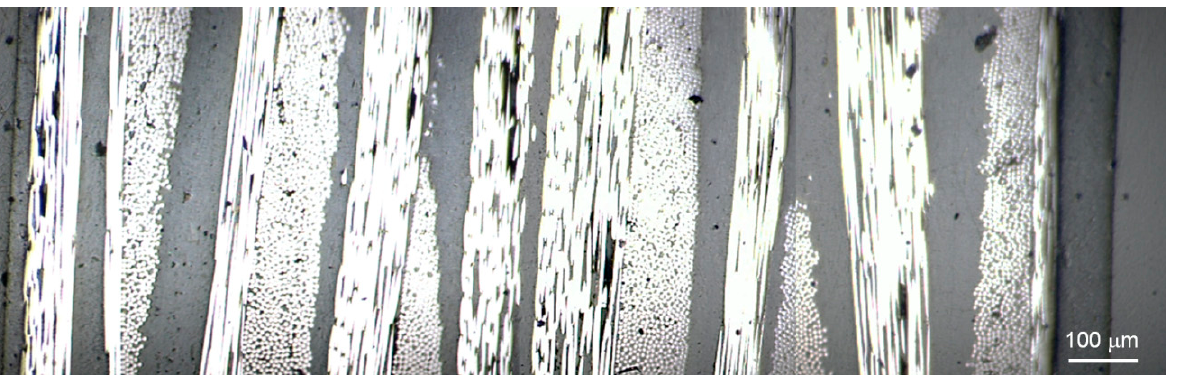
Figure 2. Photographs (upper row) and ultrasonic attenuation C-scans (bottom row) of PEEK/CF ( A , D ), PEEK-GPEI/CF ( B , E ), and PEEK-GSPEEK/CF ( C , F ). The colour scale is associated to the ul- trasonic signal attenuation measured in dB.